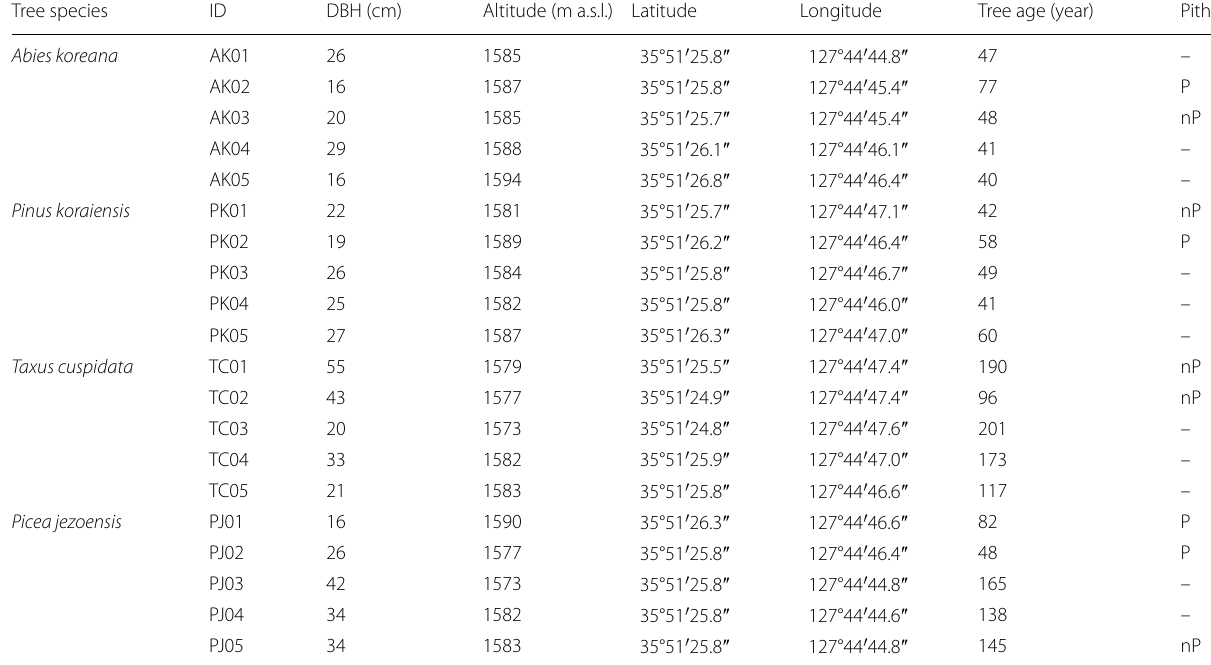
DBH: diameter at breast height, a.s.l.: above sea level, P: pith, nP: near pith